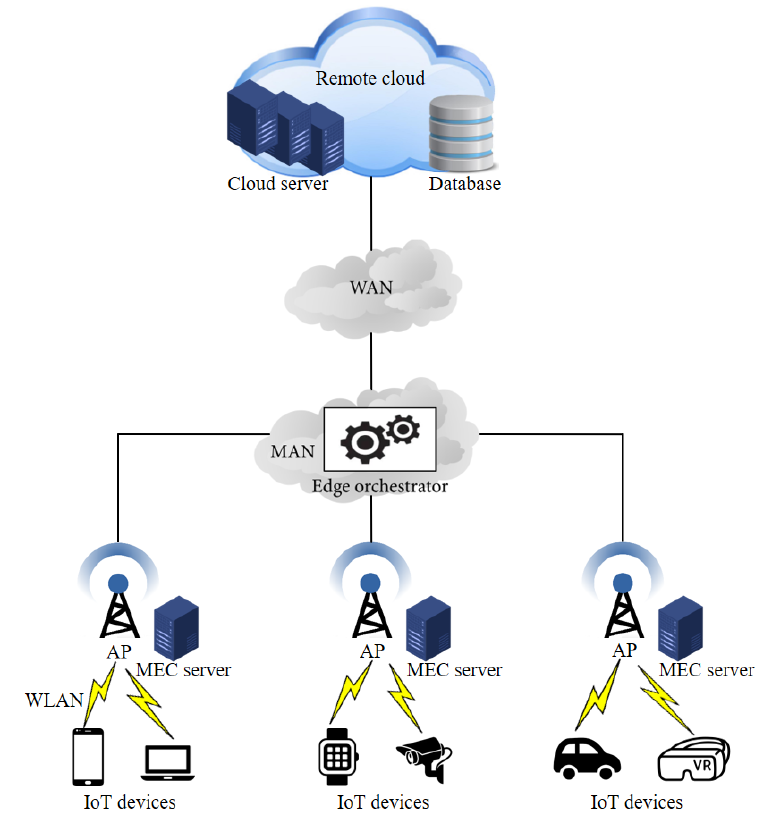
Figure 2. Proposed multi-tier MEC system